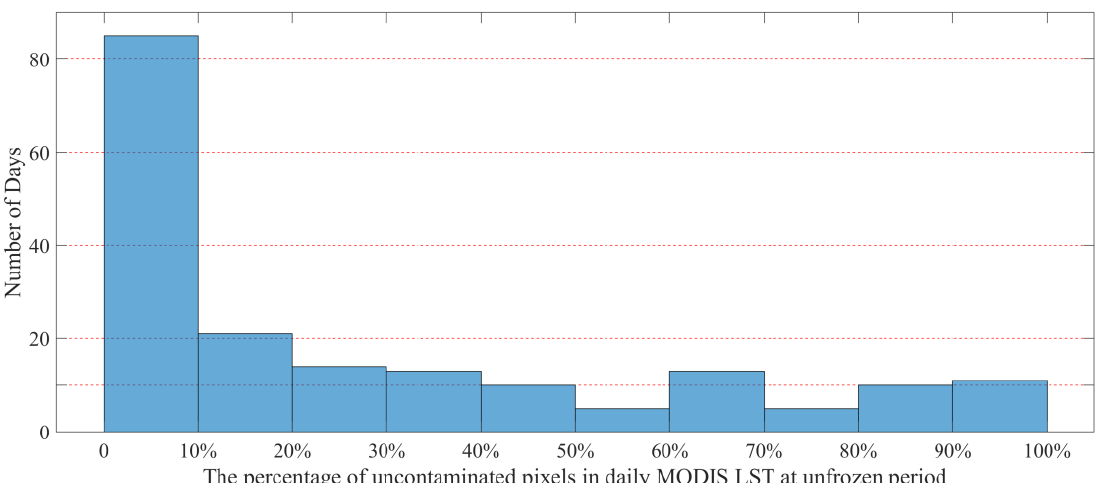
Figure 3. The histogram of percentage of uncontaminated pixels in daily MODIS LST at unfrozen period. To avoid over-fitting of SSM retrieval equation (Equation (4)) using least-squares method, the 48-sample dataset (in situ data and its corresponding remote sensing data) on 24 July 2011 is sorted by in situ SSM in ascending order. Then, the dataset is divided into five subsets at an interval of five, and the second subset with a sample size of ten is taken as the validation dataset, and the remaining 38 samples are taken as the training